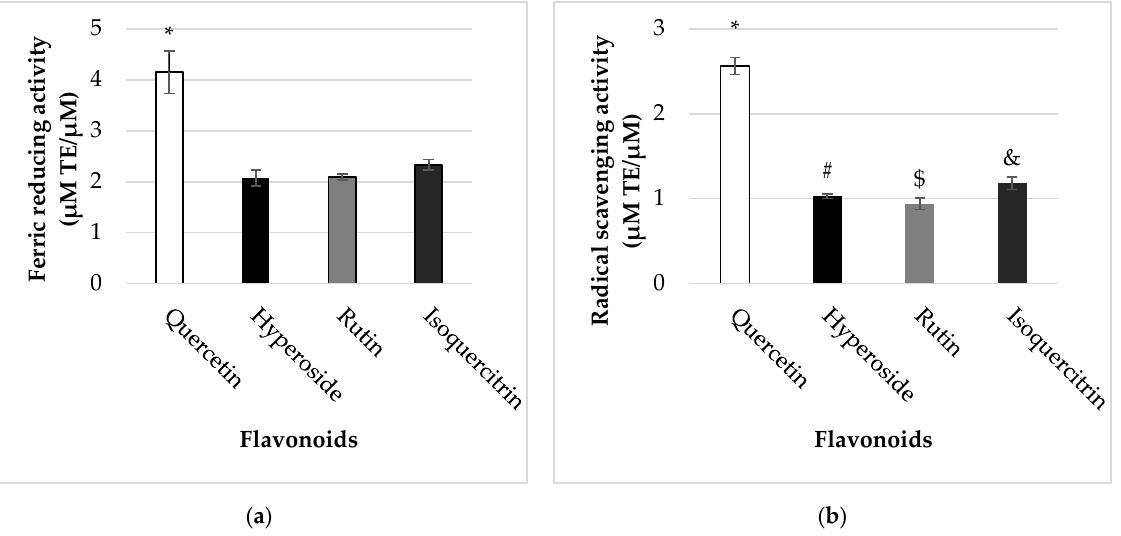
Figure 6. Ferric reducing ( a ) and radical scavenging ( b ) properties of flavonoids. Ferric reducing and radical scavenging activities of flavonoids were measured as described in Material and Methods. The antioxidant activity of flavonoids is expressed as µM Trolox equivalents (TE) for 1 µM of certain flavonoid. * Statistically significant difference ( p < 0.05) compared to hyperoside, rutin, and isoquercetin. # Statistically significant difference ( p < 0.05) compared to quercetin. $ Statistically significant difference ( p < 0.05) compared to quercetin and isoquercetin. & Statistically significant difference ( p < 0.05) compared to quercetin and rutin.